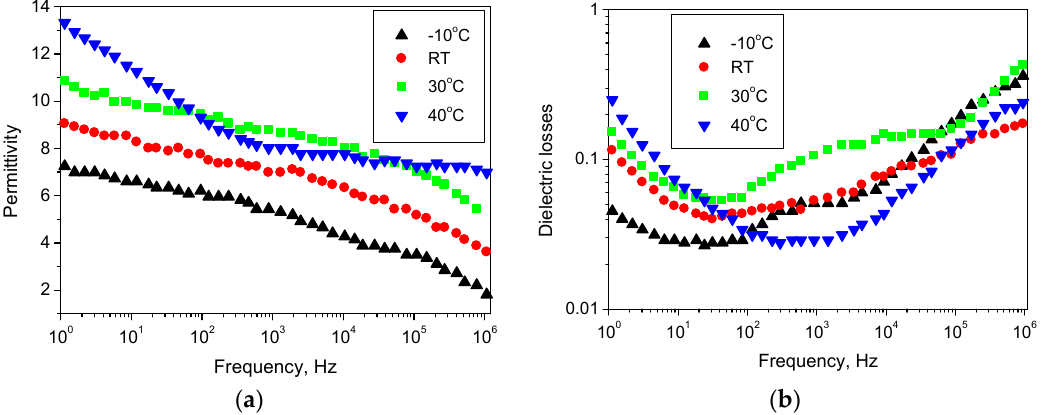
Figure 5. Frequency dependence of the ( a ) relative permittivity and ( b ) dielectric losses at different temperatures for bended sample PET/PEDOT:PSS/ZnO/PEDOT:PSS/Au. Appl. Sci. 2017 , 7 , 890